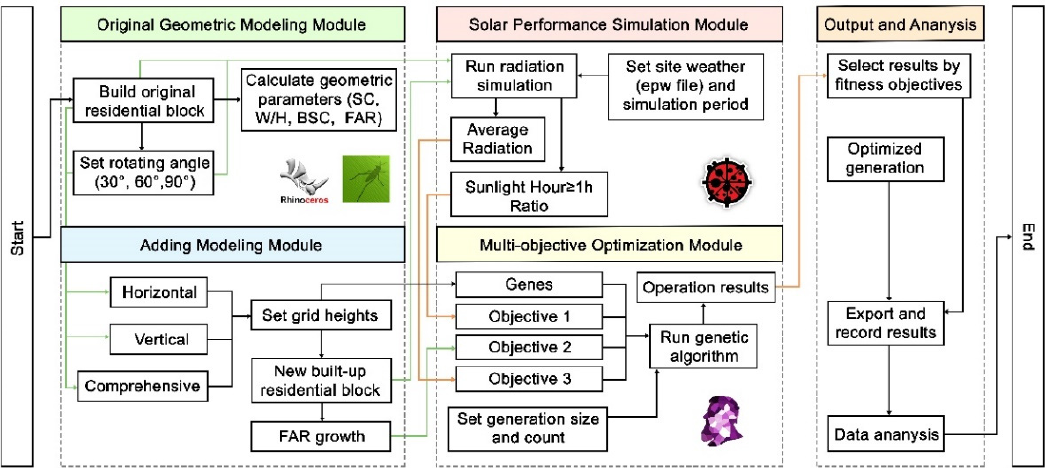
Figure 5. Optimization process of the design under three objectives.